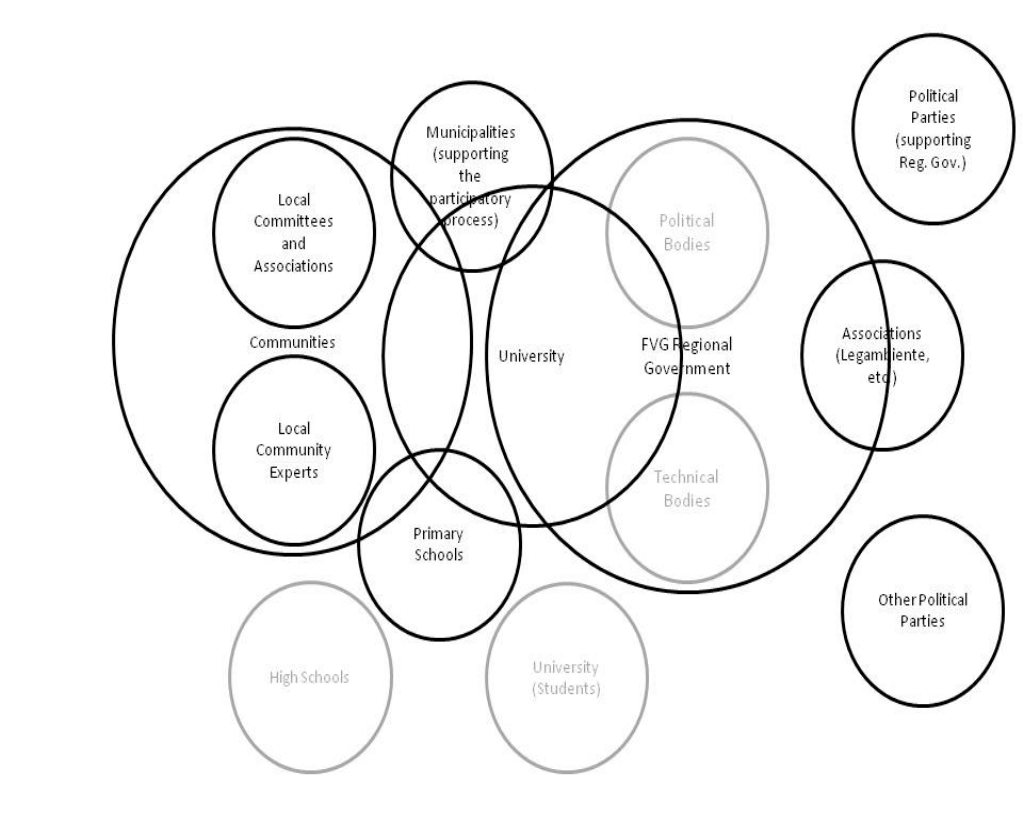
Figure 2: Bottom-up dynamics in knowledge co-production in relation to the Regional Landscape Plan of Friuli Venezia Giulia (in black, main actors; in grey, secondary